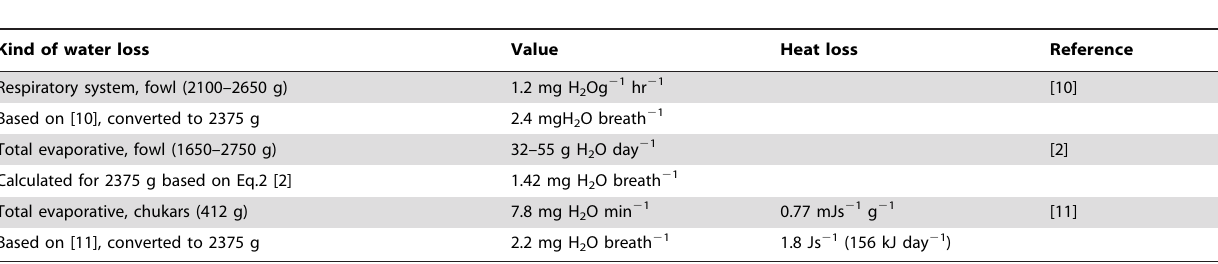
Table 3. Published values for respiratory water and heat loss in the domestic fowl.